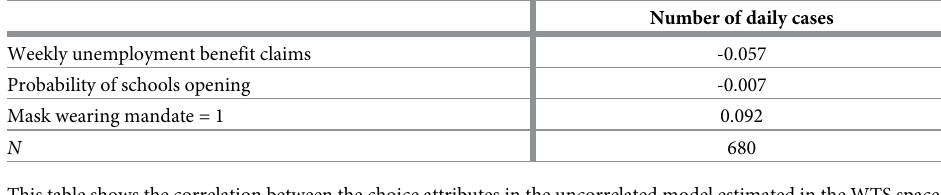
Table 4. Correlation between WTS for the main attributes.